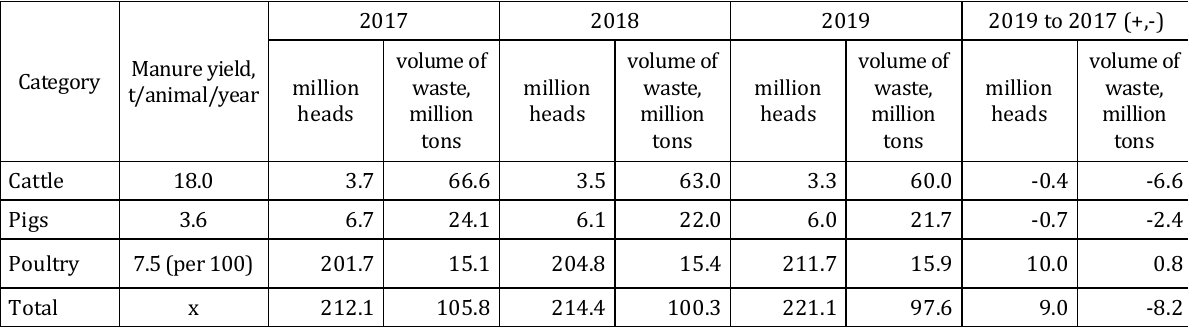
Table 5. The formation of livestock by-products (manure, litter) in Ukraine on January 1, 2019 (Source: calculated by